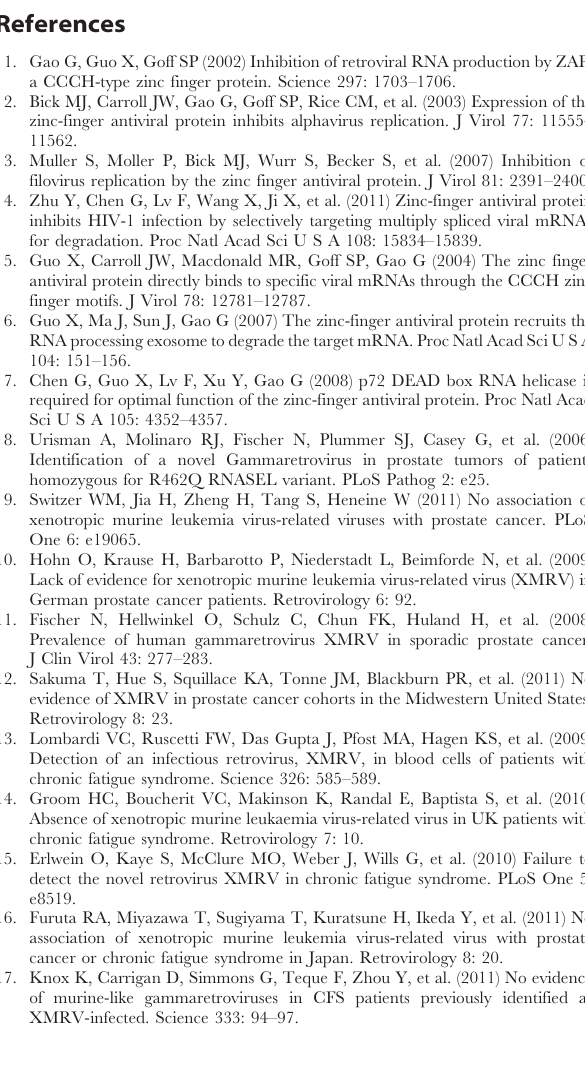
hZAP does not block the formation and nuclear entry of XMRV-luc proviral DNA. 293TREx-hZAP-v2 cells were infected with XMRV-luc virus at the indicated dilutions. At 6 h postinfection, cells were mock treated or treated with 1 m g/ml tetracycline. At 24 h postinfection, cells were lysed and Hirt DNA was extracted. The 2-LTR junction of the nuclear circular viral DNA was detected by PCR. PCR product of mitochondrion